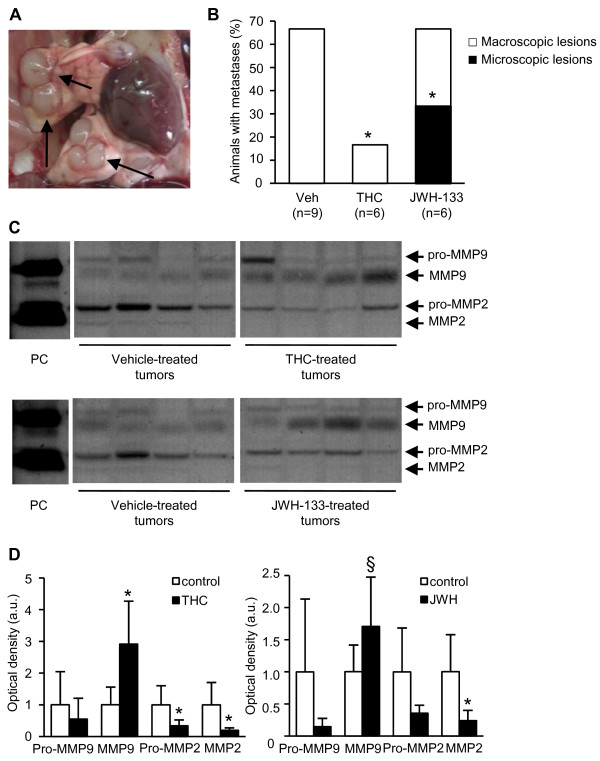
Cannabinoids inhibit breast cancer metastasis to the lungs in vivo. (A) Metastatic lung nodules (pointed by arrows). (B) Percentage of animals with lung metastases. Macroscopic metastases were visible to the naked eye and microscopic lesions were detectable only by H&E staining. These latter lesions were found only in JWH-133-treated animals. (C) Gelatin zymographies of vehicle- and cannabinoid-treated tumors. Four representative tumors are shown per experimental group. PC: positive control (conditioned medium of H71080 cells stimulated with the phorbol ester PMA). Arrows point to the latent (pro-MMP) and active MMP bands according to the positive control and the expected MMP molecular weights. Non-contiguous parts of the same gel are shown. Graphs show the densitometric analysis of MMP2 and MMP9 activities. Data are expressed in arbitrary units. *, p < 0.05 vs vehicle-treated tumors; §, p = 0.068 vs vehicle-treated tumors.